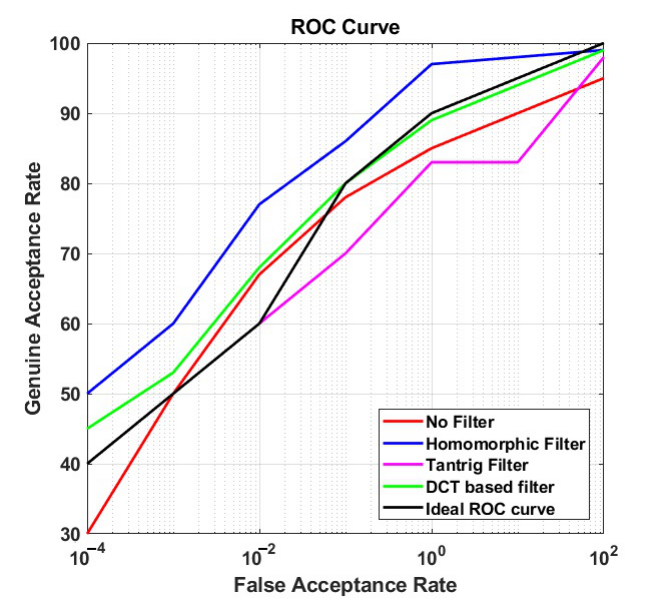
Figure 7. The ROC curves of the proposed method applied to CS face matching at a long distance (60 m) with the BLPOC frequency band